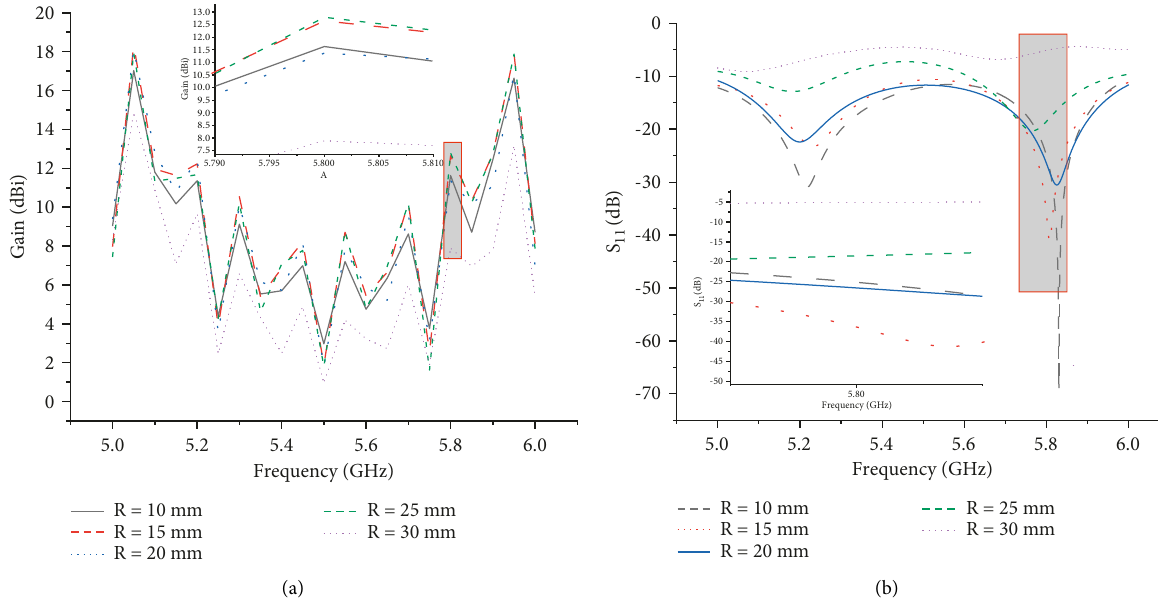
Figure 11: Frequency behavior of the gain (a) and of the magnitude of antenna S-parameter (b) for different values of the curvature radius of the semicircular